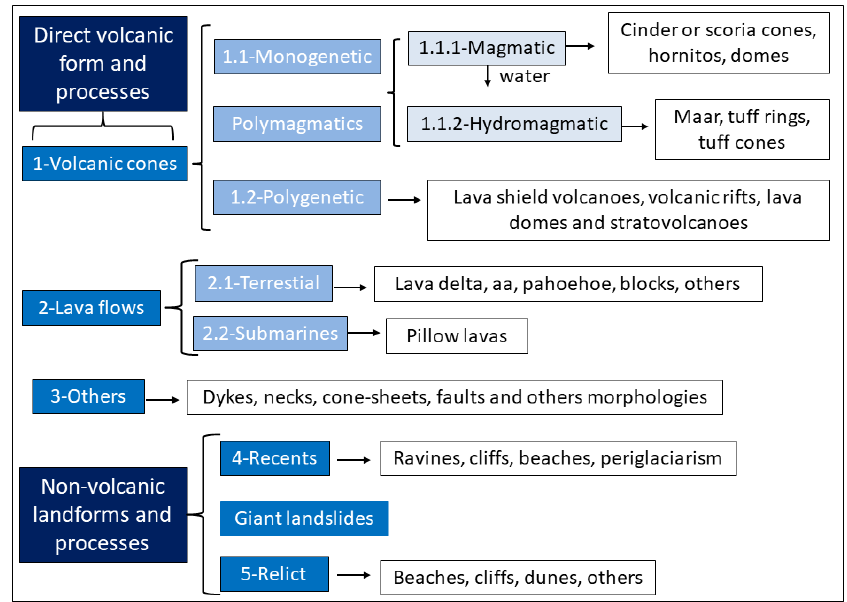
Figure 3. Scheme of volcanic and non-volcanic geomorphological classifications. For the consult the glossary of specific terms you can visit: https://volcanoes.usgs.gov/vsc/glossary/ .